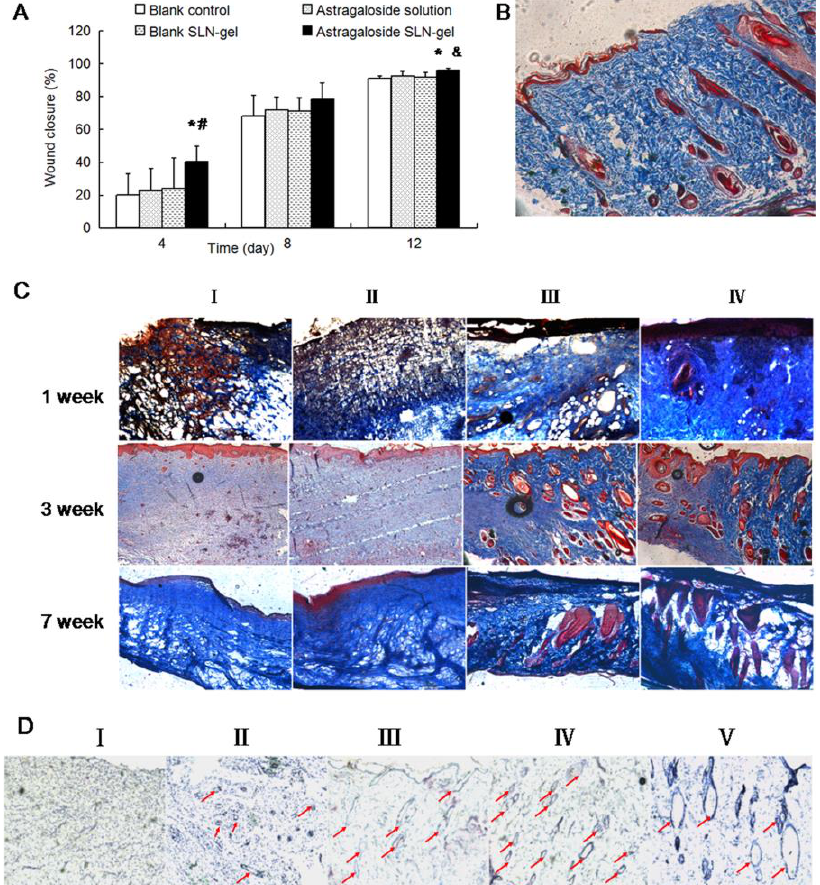
Figure 4. Effect of hydrogel containing Astragaloside IV-loaded SLN in wound healing and anti-scar potential after skin application. ( A ) Wound closure percentage (* p < 0.05, blank control; # p < 0.05, astragaloside IV solution; & p < 0.05, blank SLN-hydrogel). ( B ) Masson’s trichrome staining of normal skin. ( C ) Masson’s trichrome staining at 1-, 3-, and 7-weeks post-wounding: ( I ) blank control; ( II ) blank SLN-hydrogel; ( III ) astragaloside IV solution; and ( IV ) astragaloside IV SLN-hydrogel. ( D ) CD31 immunohistological staining at 3 weeks post-wounding: ( I ) blank control; ( II ) blank SLN-hydrogel; ( III ) astragaloside IV solution; ( IV ) astragaloside IV SLN-hydrogel; and ( V ) normal skin (red arrows indicate newly formed blood vessels). Figure reproduced with permission from Chen and co-workers